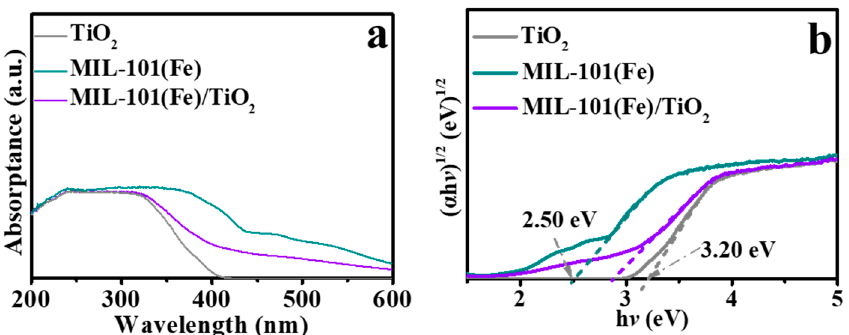
Figure 4. ( a ) UV − Vis spectra of the as-prepared samples; ( b ) plots obtained using the Kubelka − Munk Figure 4. ( a )UV − Vis spectra of the as ‐ prepared samples; ( b ) plots obtained using the Ku ‐ belka − Munk function transformation for the calculated absorbance versus photon energy. function transformation for the calculated absorbance versus photon